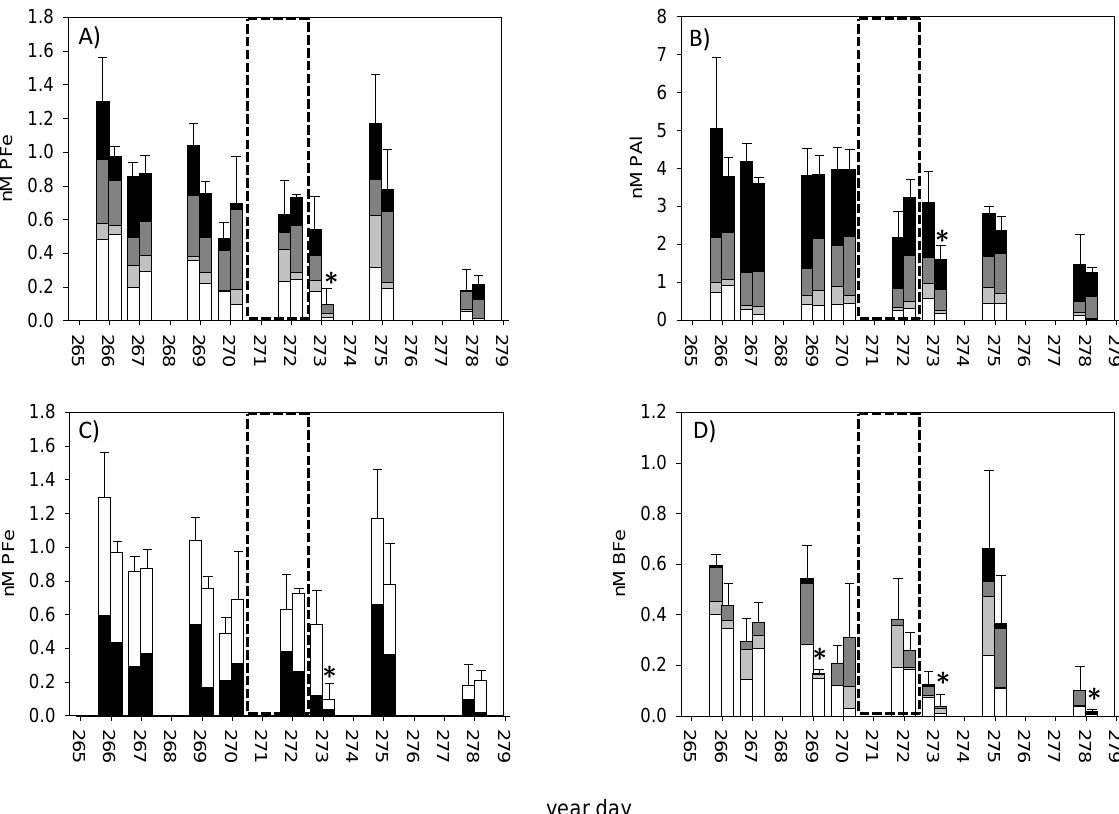
Fig. 4. ICPMS-based particulate Fe (PFe), particulate Al (PAl), and calculated biogenic Fe (BFe) concentrations at 30 and 60m over the course of the experiment. (A) Total nM PFe and stacked by size fraction, (B) total nM PAl and stacked by size fraction, (C) total nM PFe with lithogenic Fe (LFe) stacked on top of biogenic Fe (BFe), and (D) total nM BFe and stacked by size fraction. Stacked data represent (top to bottom) the > 20µm, 5–20µm, 2–5µm, and 0.2–2µm fractions. For each day, left bar=30m, right bar=60m. The transition between the two phases of the study is marked by the dashed line rectangle. Error bars represent 1 standard deviation ( n = 3). Significant differences between 30m and 60m total values designated by asterisk ( p < 0 .